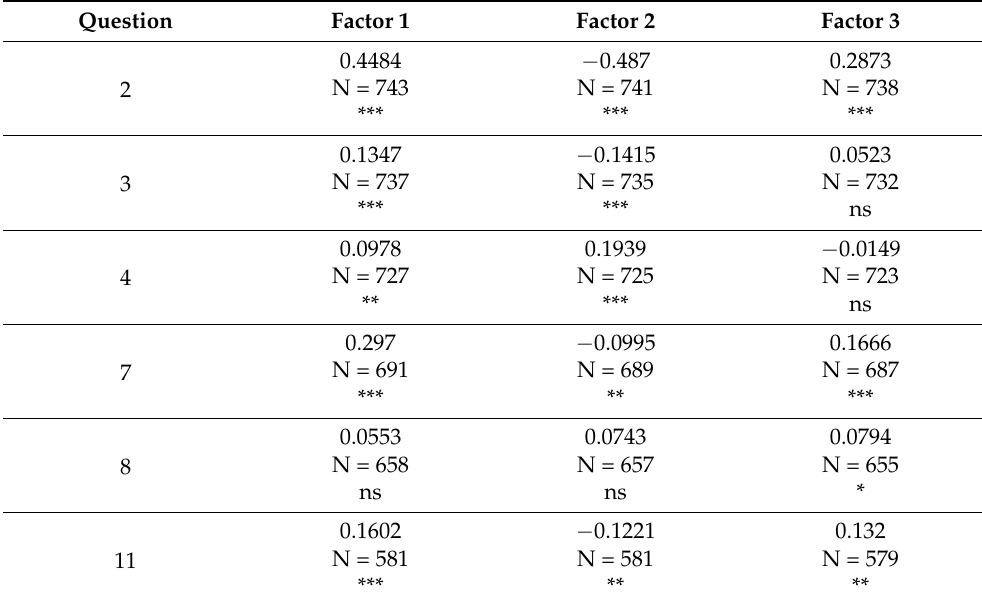
Table 8. Pearson’s linear correlations between the factors describing the specificity of the nursing profession and the issues of occupational burnout. Question Factor 1 Factor 2 Factor 3 2